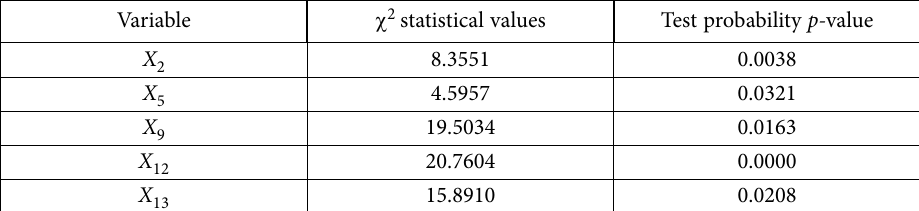
Table 2. c 2 statistical values and test probabilities p